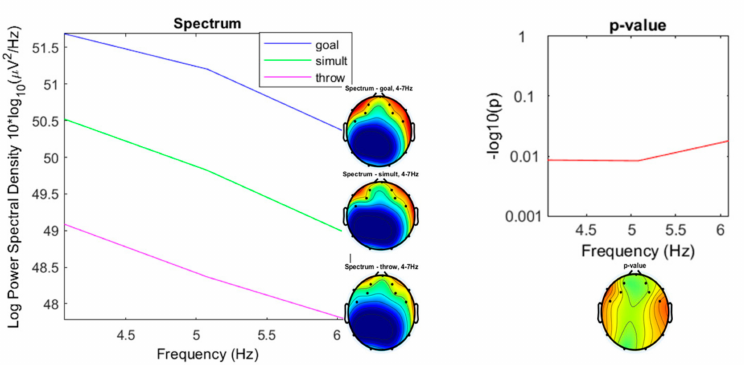
Figure 8. Spectrum plotting of the three conditions components (“throwing,” “goal,” “simultaneous”), with their plot averaged topography over frequency range, and the p -value plot for frequencies from 4 to 30 Hz.